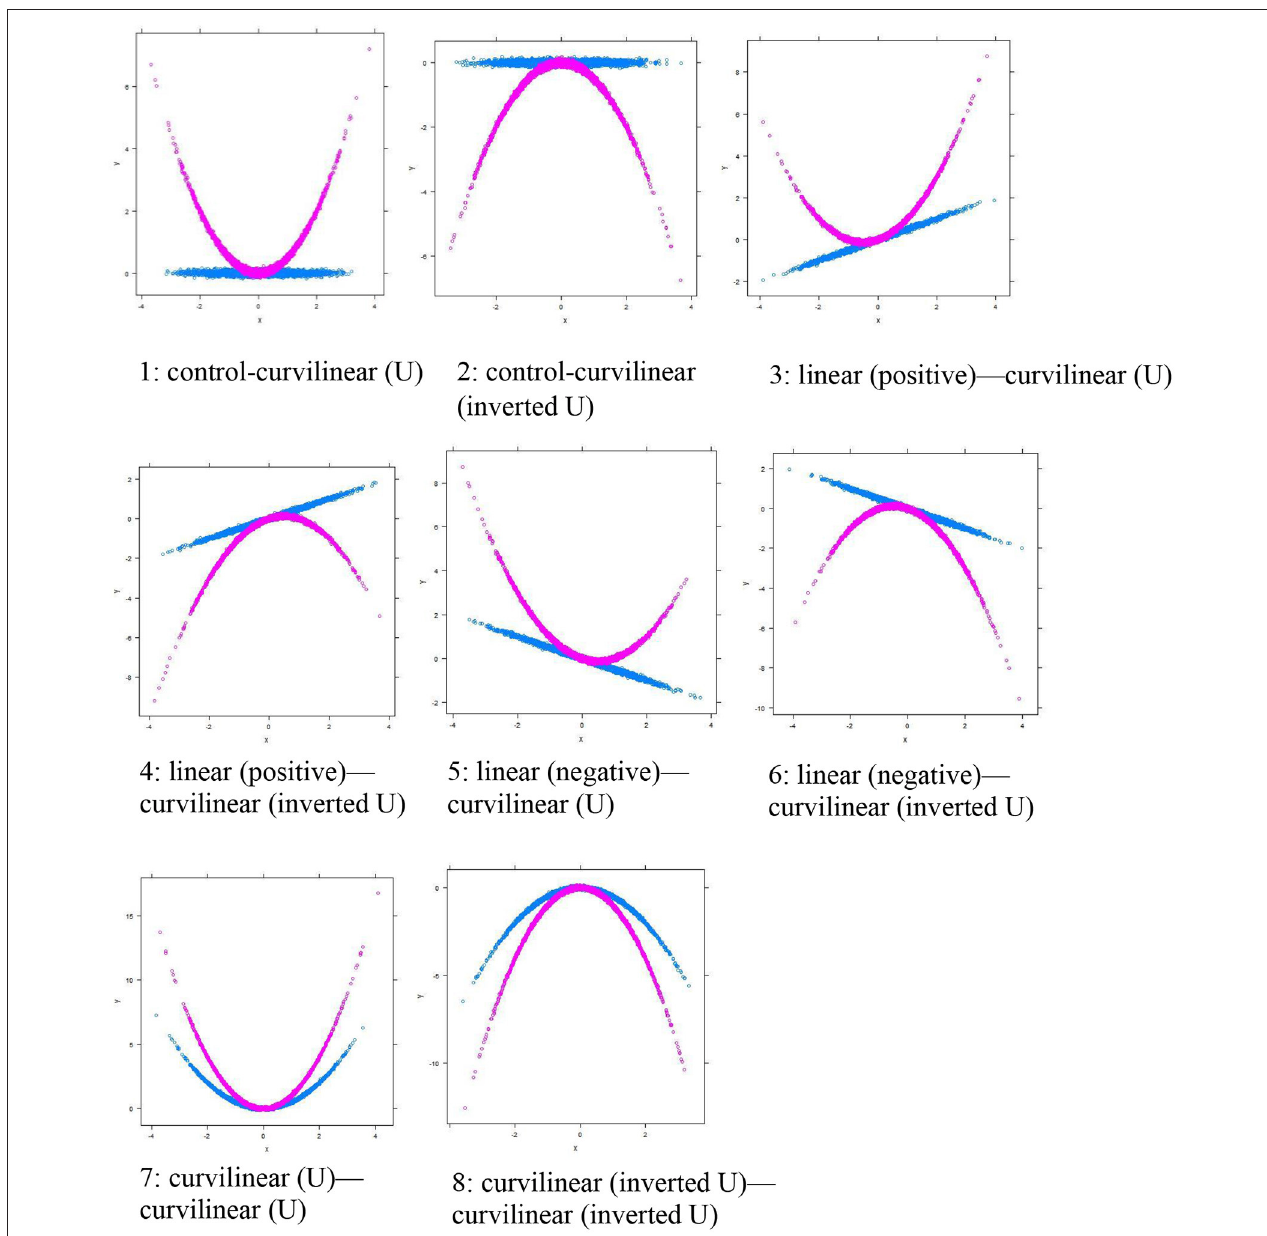
FIGURE 2 | Eight types of Curvilinear Moderations (Categorical). The blue line shows the group of observations with a lower score in the moderator M (i.e., Group 0). The purple line shows the group of observations with a higher score in the moderator M (i.e., Group 1).